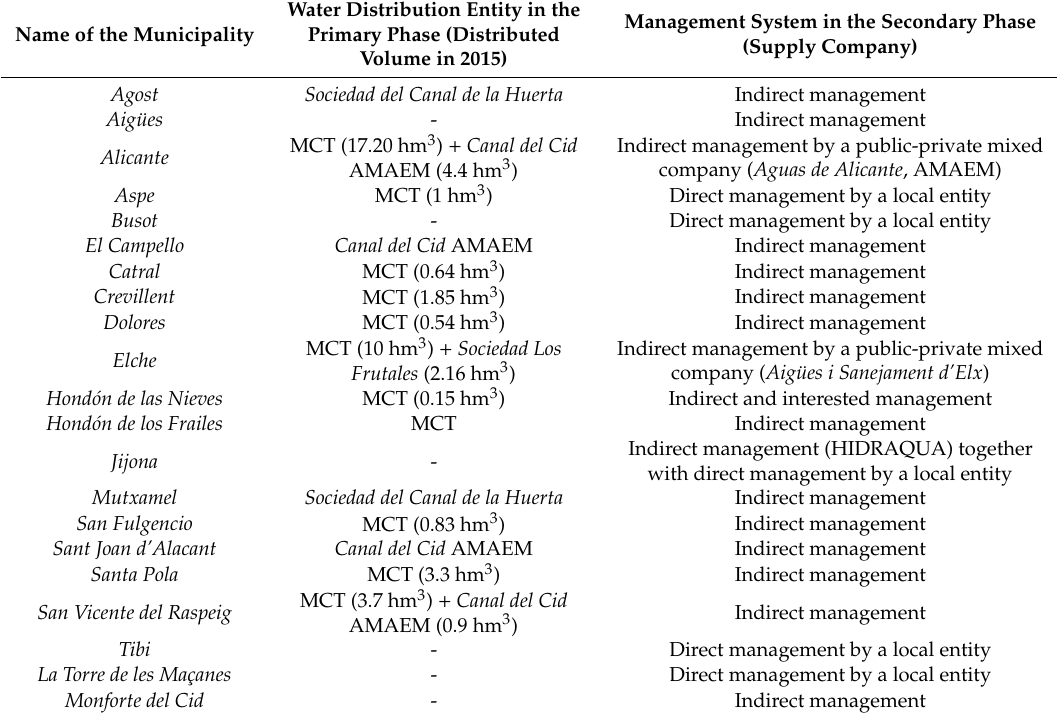
Table 4. Types of urban and industrial water management in the study area. Source: own elaboration from